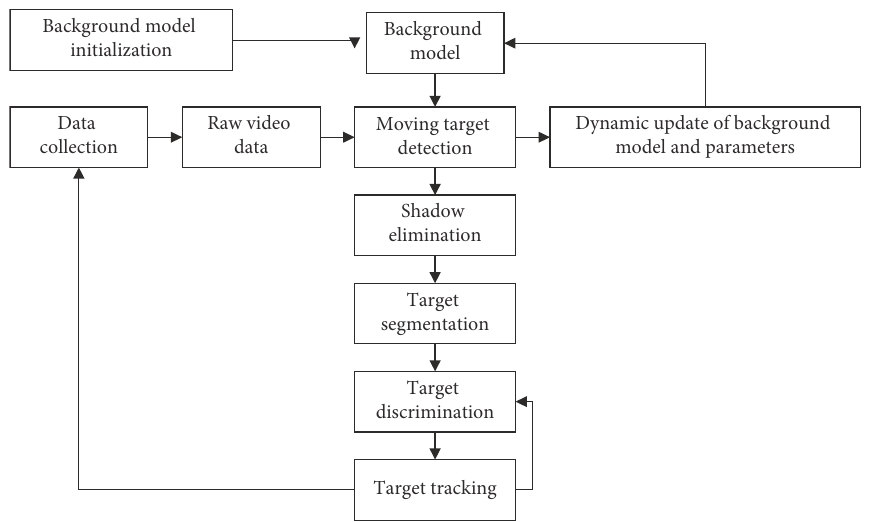
Figure 2: Moving target detection and tracking program structure diagram. Table 1: Summary of reliability test